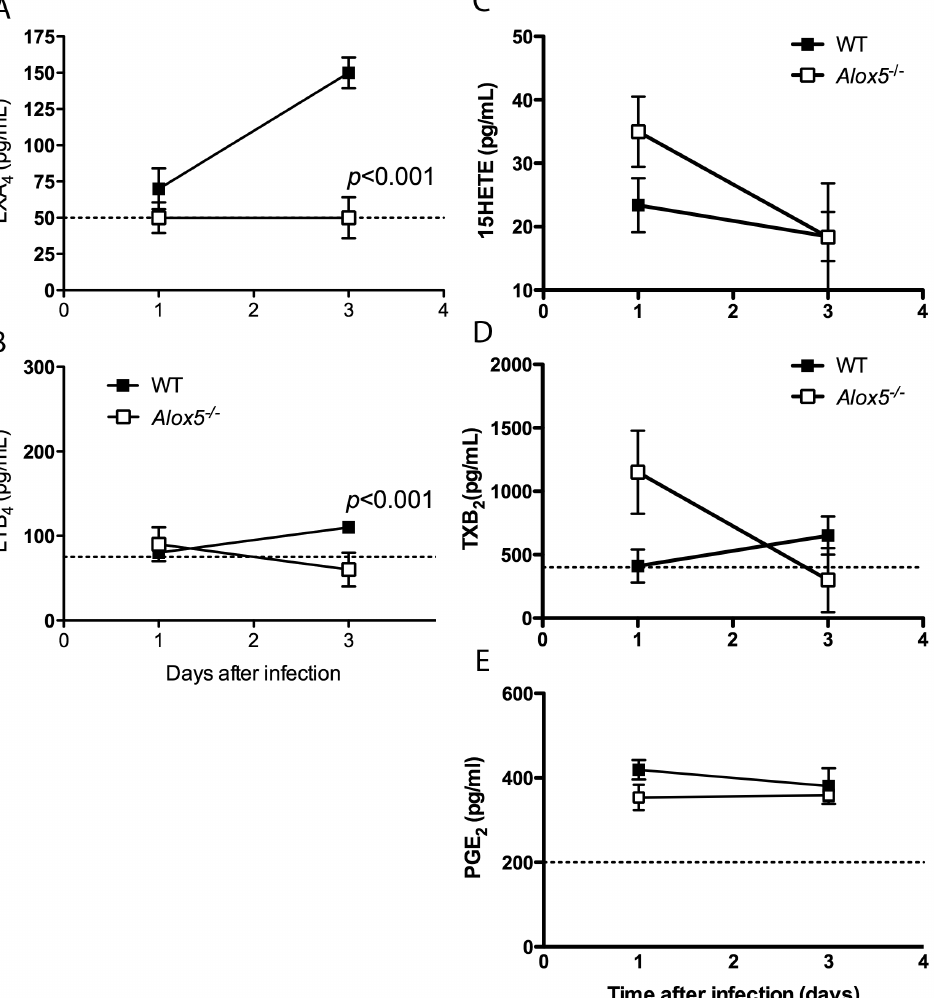
Figure 3. P.berghei ANKA infection induces LO-dependent lipid mediator synthesis. C57Bl/6 WT and Alox5 2 / 2 ( n =4 mice/group) mice were infected i.p. with P. berghei ANKA strain. At 1 and 3 days after infection, animals were bled and serum levels of LXA 4 ( A ), LTB 4 ( B ), 15HETE ( C ), TXB 2 ( D ) and PGE 2 ( E ) were determined by ELISA. Data shown is representative of one out of three independent experiments performed. Statistical analysis of difference among groups was determined using Mann Whitney test.